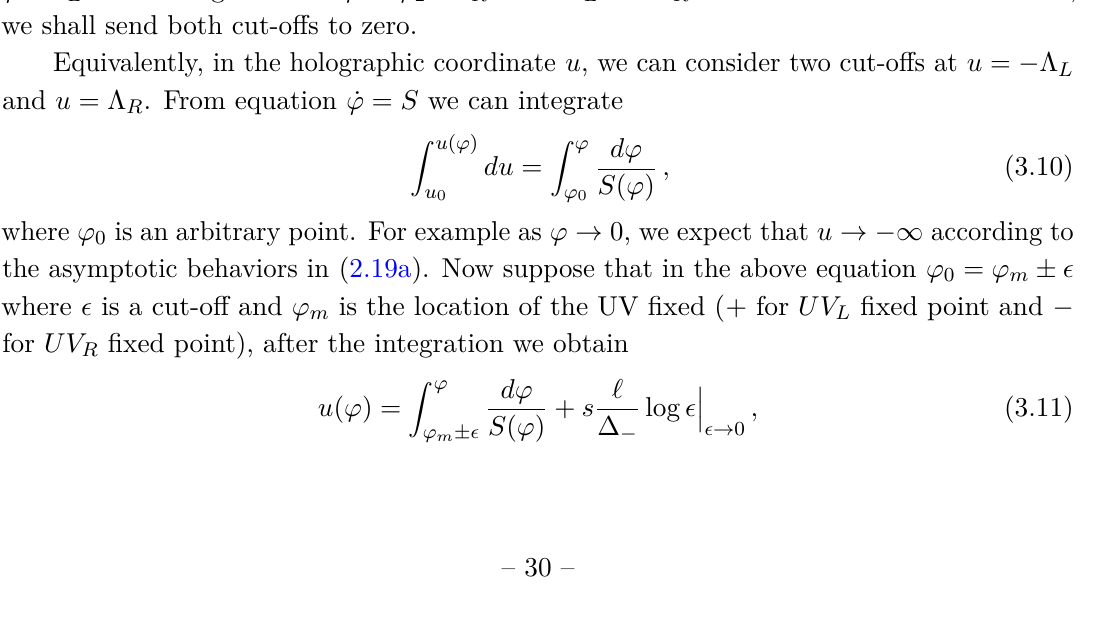
solution with the two cut-offs (red dashed 1 , 0